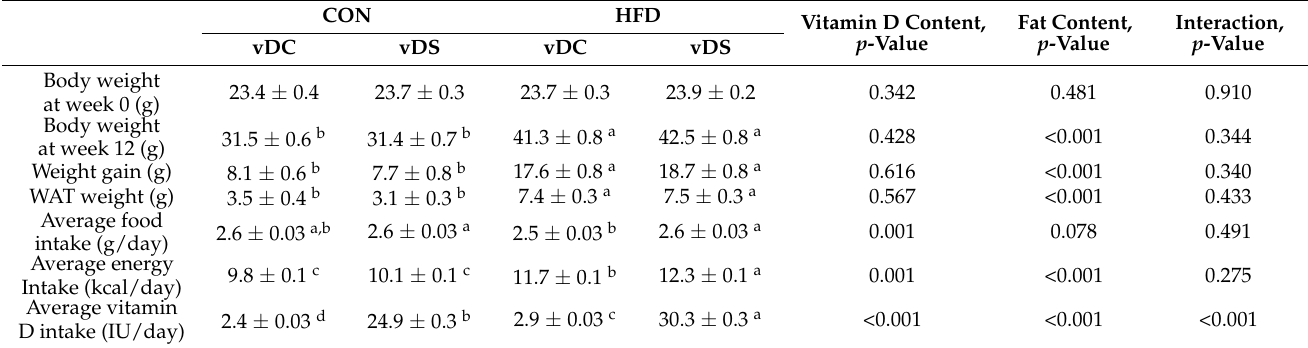
Table 3. Body weight, weight change, adipose tissue weight, and food intake.